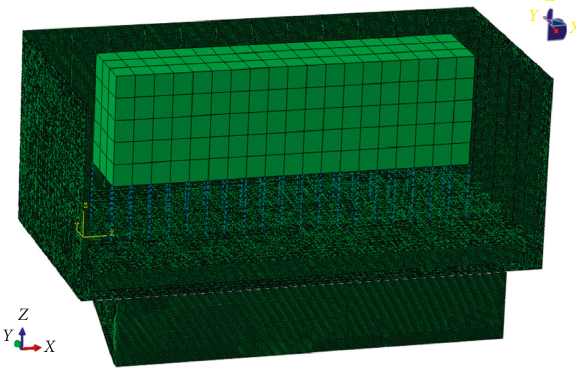
Figure 12: Finite element model of the IFSP.